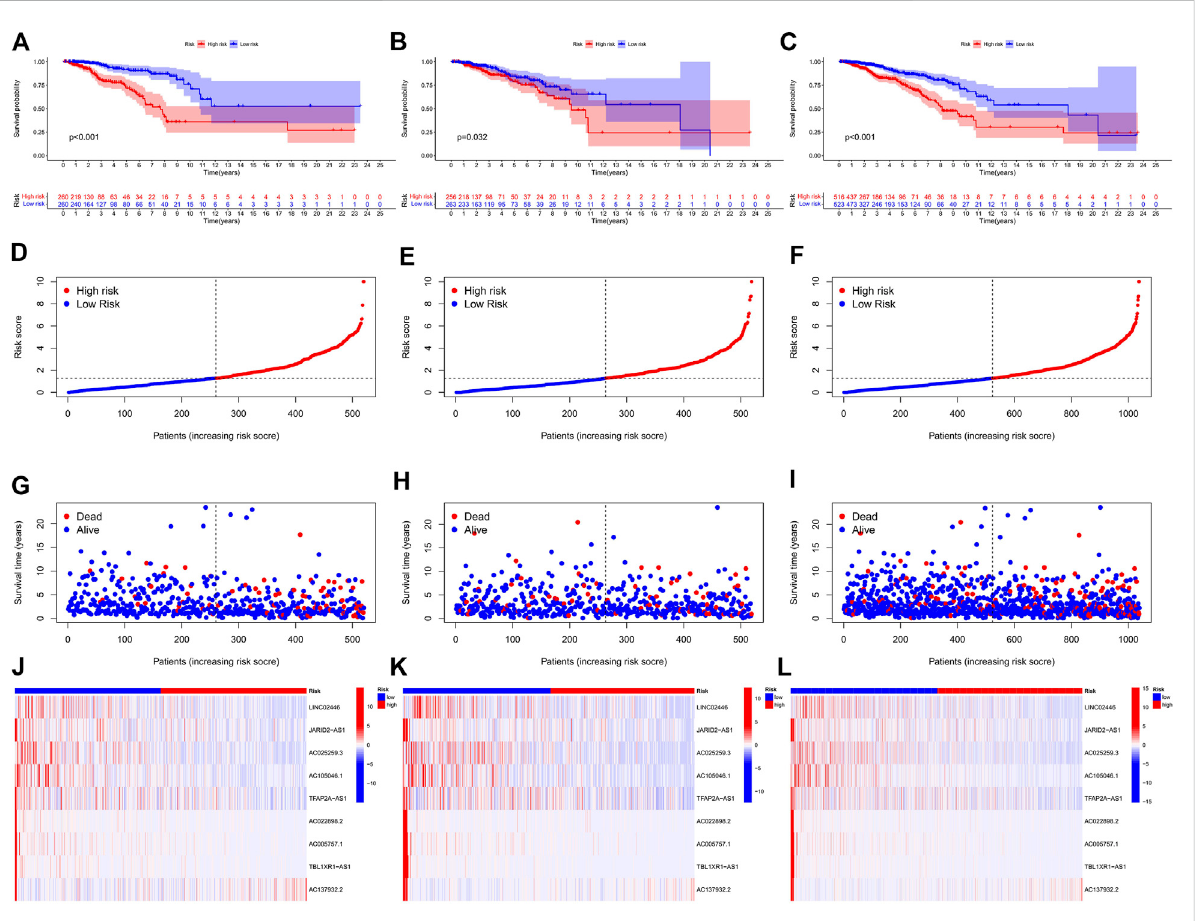
FIGURE 2 Prognosis and risk scoring analysis of 9 ERS-related lncRNAs in the different sets for BC patients. (A – C) Kaplan – Meier survival curves of BC patients ’ OS in the high- and low-risk groups in the training (A) , validation (B) , and complete sets (C) . (D – F) Risk score distribution in the training (D) , validation (E) , and complete sets (F) for two groups. (G – I) Scatter plots of BC patient survival status distribution in the training (G) , validation (H) , and complete sets (I) . (J – L) Risk heatmaps of the 9 ERS-related lncRNA expression in the training (J) , validation (K) , and complete sets (L) . Red represents high expression and green represents low expression. ERS, endoplasmic reticulum stress; BC, breast cancer; OS, overall